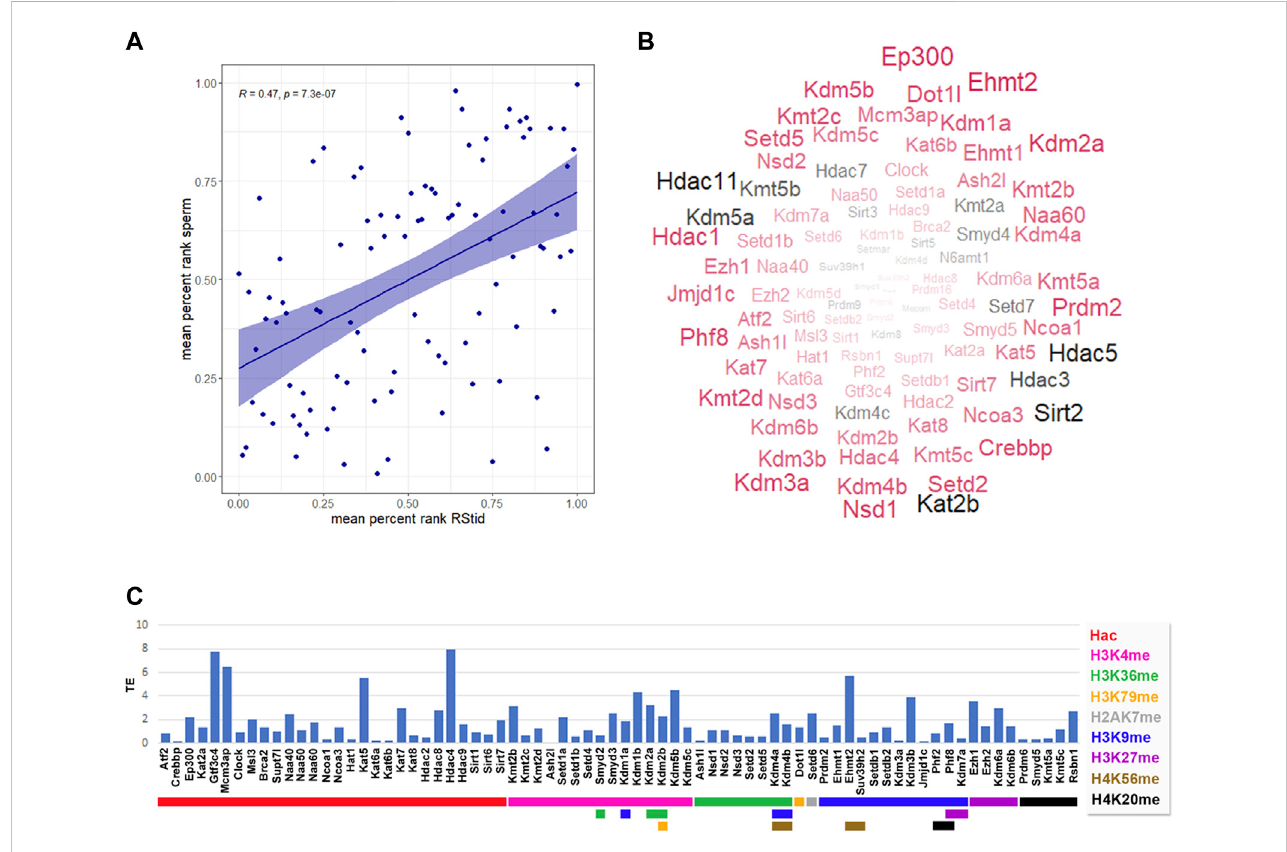
FIGURE 7 Epigenetic histone K writers and erasers detected at mature sperm RNA cargo and 1-cell embryo translatome. (A) Pearson correlation between epigeneticenzymesmeanpercentrankdetectedatRStidandsperm. (B) Maturespermwordcloudforepigeneticenzymesindicating theenzymeabundance (word size = mean percent rank) and translation ef fi ciency (TE) detected at one cell embryo (red: TE > 0, black: TE = 0). (C) Epigenetic enzymes TE in mouse pre-implantation embryos (TE = RNA RPKM at ribosome/total RNA RPKM, RPKM > .5). Red arrows indicate epigenetic enzymes that showed increased total RNA values in the one-cell embryo compared to the meiosis II (MII oocyte), indicative of possible paternal contribution to the zygotic mRNA